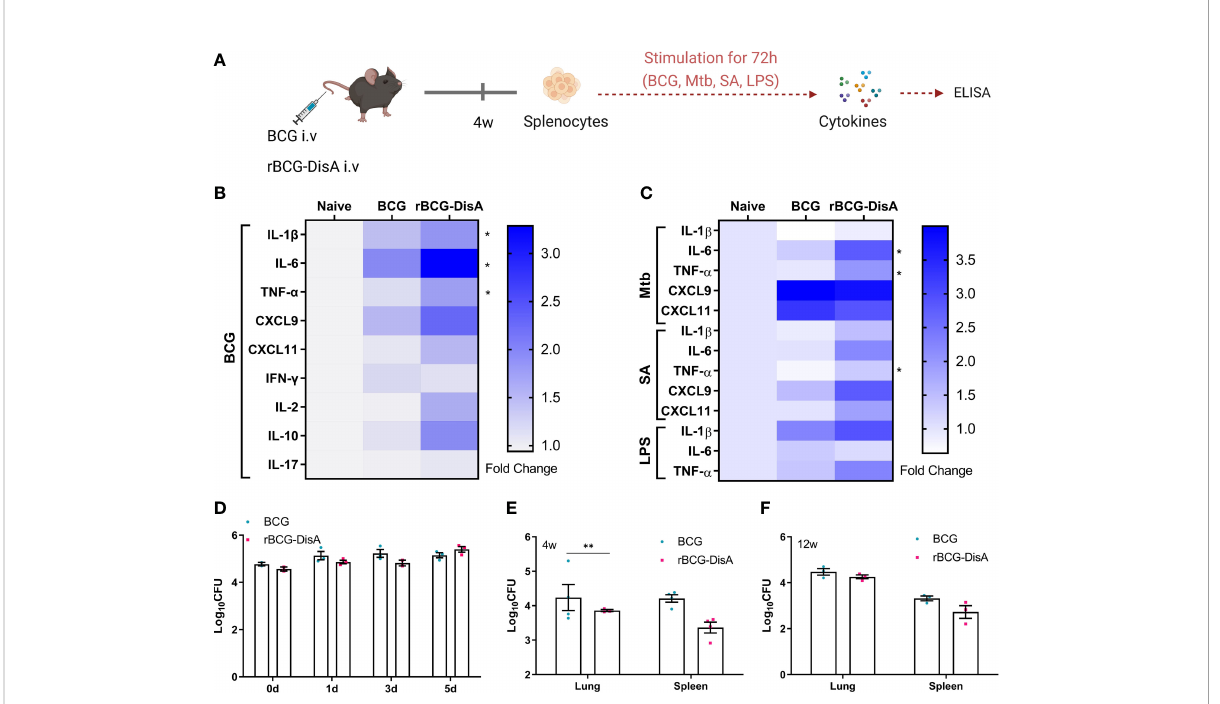
FIGURE 1 In fl ammatory cytokine levels of rBCG-DisA i.v vaccinated mice and intracellular survival of rBCG-DisA in macrophages and mice. (A) Schematic diagram of homologous or heterologous stimulation of splenocytes in vitro (created with BioRender.com). After 4 weeks of BCG and rBCG-DisA i.v vaccination, splenocytes were isolated and re-stimulated with BCG protein extracts (BCG) (25 m g/mL), M. tuberculosis (Mtb) (25 m g/mL), S. aureus (SA) (25 m g/mL), and E. coli O111:B4 LPS (LPS) (100ng/mL) for 72h in vitro . Normal mice (Naïve) were used as control. Supernatants were collected to measure cytokine secretion level by ELISA. (B, C) Cytokines and chemokines production of IL-1 b , IL-6, TNF- a , CXCL9, CXCL11, IFN- g , IL-2, IL-10 and IL-17 in supernatants were determined after re-stimulations by ELISA. The results are expressed as relative folds of each cytokine concentration (ng/mL) compared to the Naïve group ( n =3). (D) Intracellular survival of BCG and rBCG-DisA in RAW264.7 macrophages at 0, 1, 3, and 5 days post infection (MOI=10). (E, F) The number of bacilli in the lung and spleen of mice was measured after 4 (E) and 12 (F) weeks of i.v immunization, respectively ( n =3). (Panels B, C , * P < 0.05 stands for rBCG-DisA v.s BCG group. Panel E , ** P <